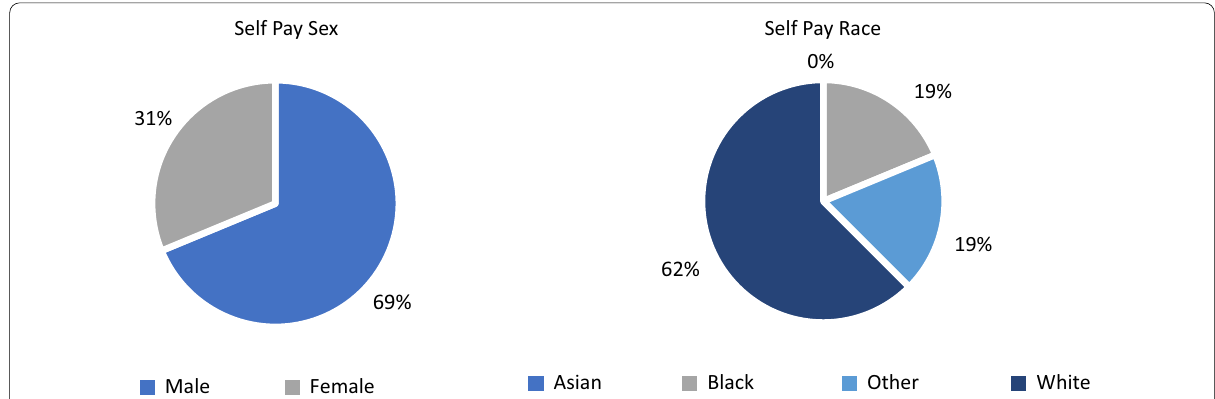
Fig. 1 Breakdown of self-pay patients by sex and race. Of the 16 self-pay patients, 5 were female and 11 were male. Three were Black, 3 were other and 10 were White (Additional file